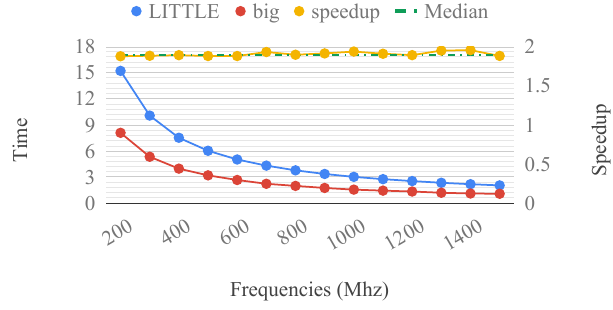
Figure 3. Performance parameter perf fitted for the architecture using a fixed number of operations of the stress-ng tool for one core of each